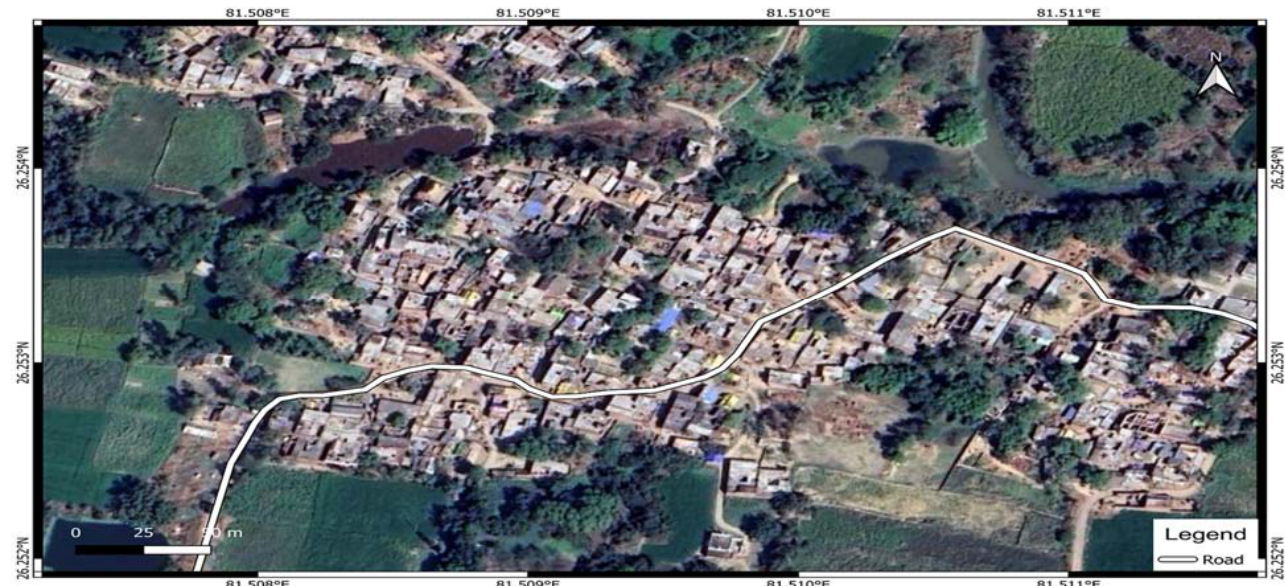
Figure 3. Study area location at Pure Ganga Gaon.